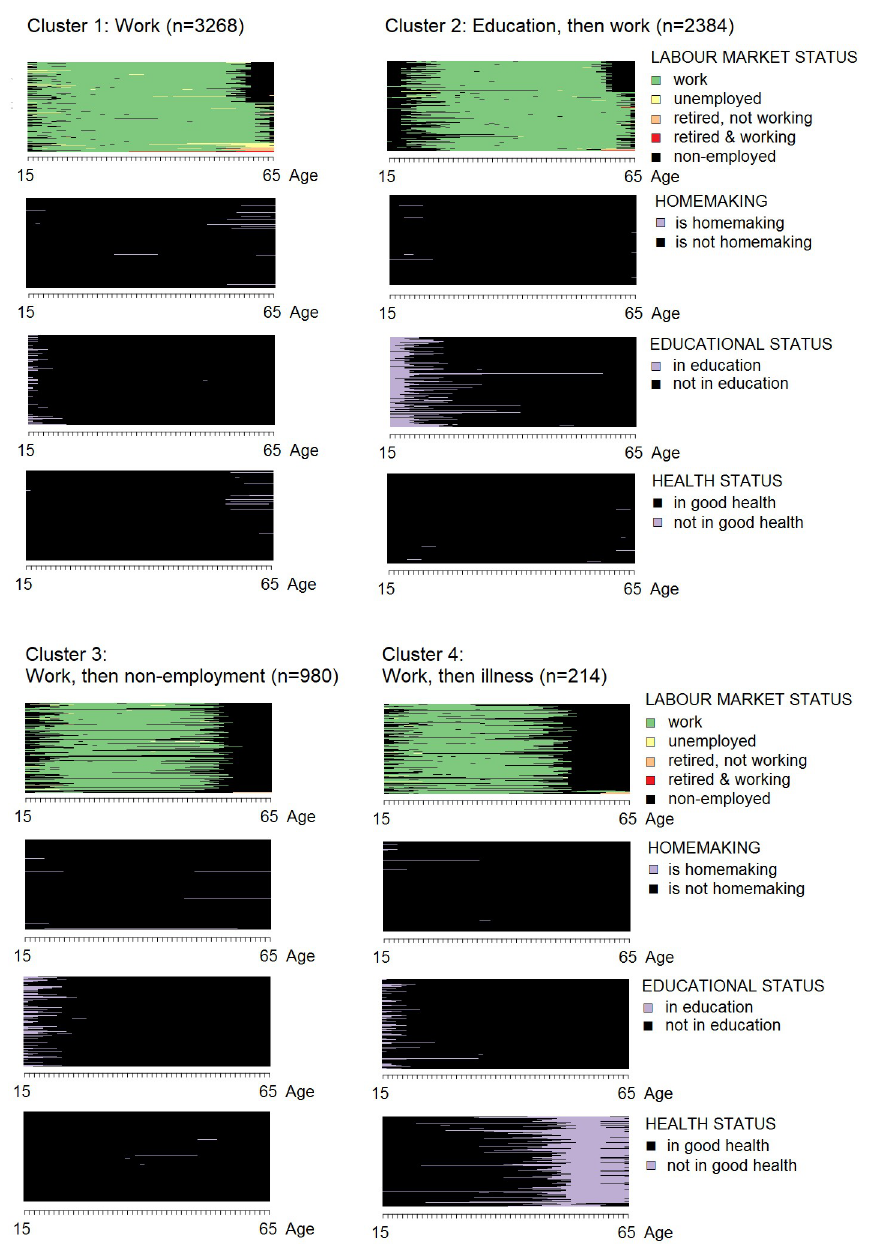
Fig 4. Working age life-course clusters among